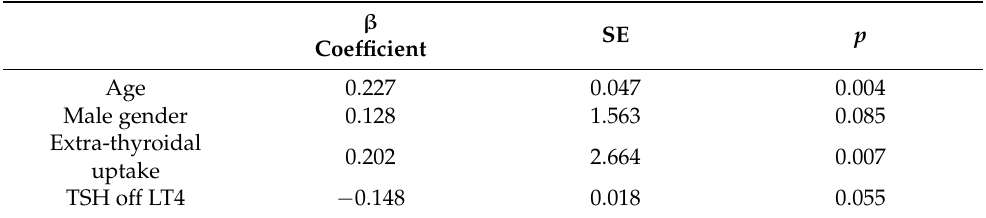
Table 2. Multivariable linear regression analysis after backward variable selection to predict whole- body effective 131I